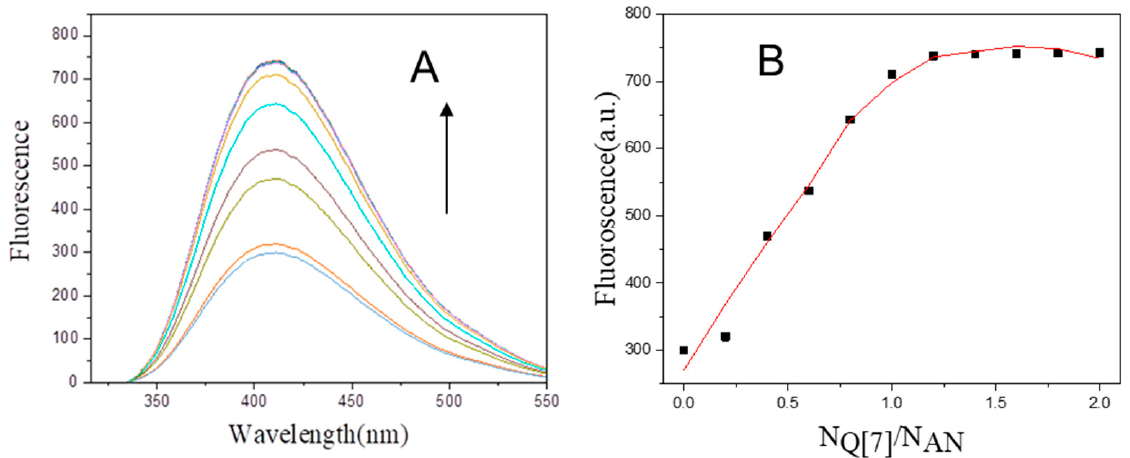
Figure 4. ( A ) The fluorescence spectroscopy of the solution of AN with adding Q[7] at different concentrations. ( B ) The fluorescence intensity at maximum fluorescence emission wavelength cor- responding to the ratio of N (Q[7]) /N (AN).